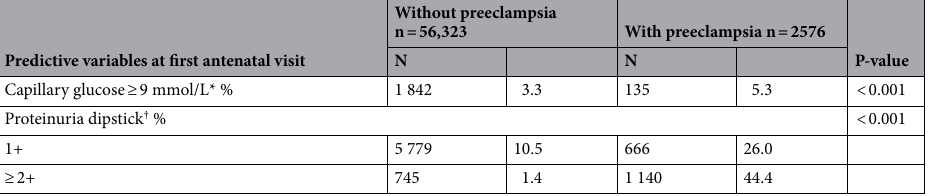
(Fig. S1). The departure of the woman’s trajectory from the non-preeclamptic population’s mean trajectory is represented by the standard deviations, u-scores (similar to z-scores), for each of the three features, for